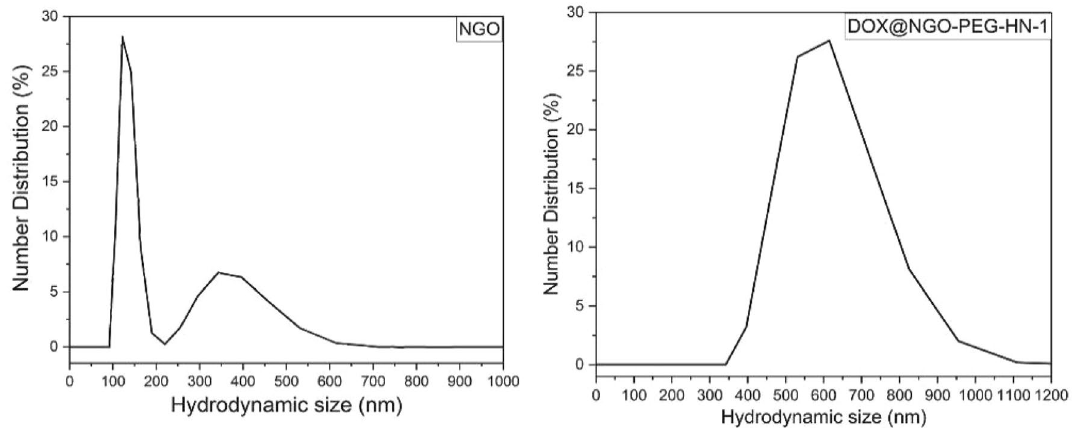
Figure 4. The particle size distribution: number distribution of NGO and